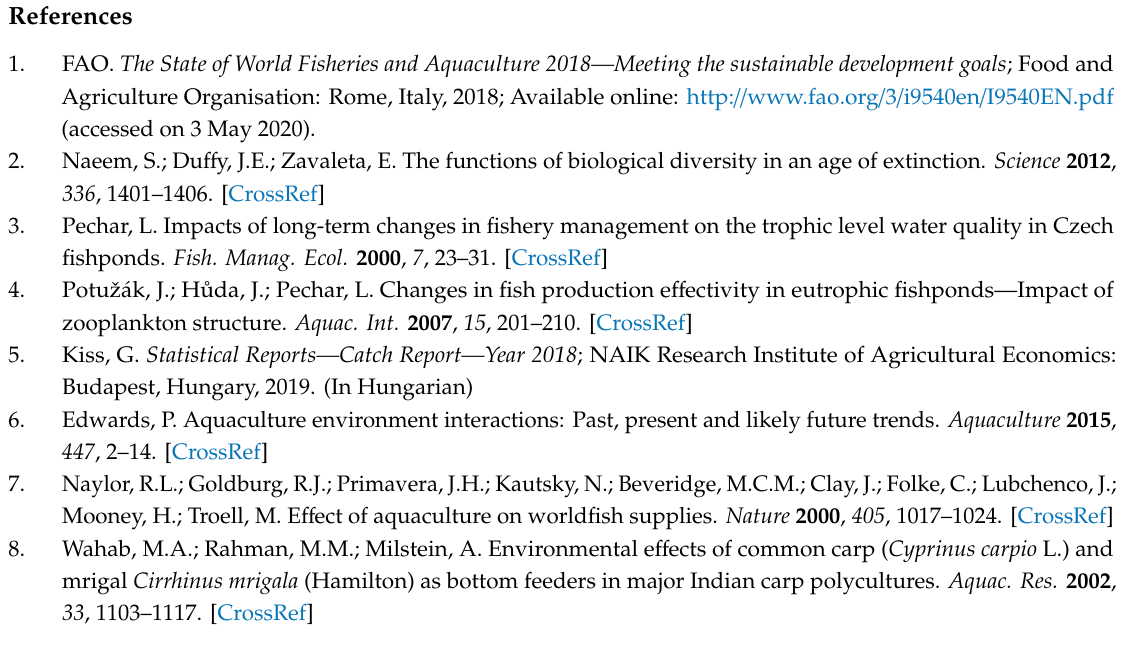
Table S1: The list of rotifera species of the fishponds according to the treatments, and the calculated number of individuals; CT—Control; FF—Fishmeal-based diet; PF—Plant meal-based diet (PF); SD—Standard deviation; Table S2: The list of Crustacea species of the fishponds according to the treatments, and the calculated number of individuals; CT—Control; FF—Fishmeal-based diet; PF—Plant meal-based diet (PF); SD—Standard